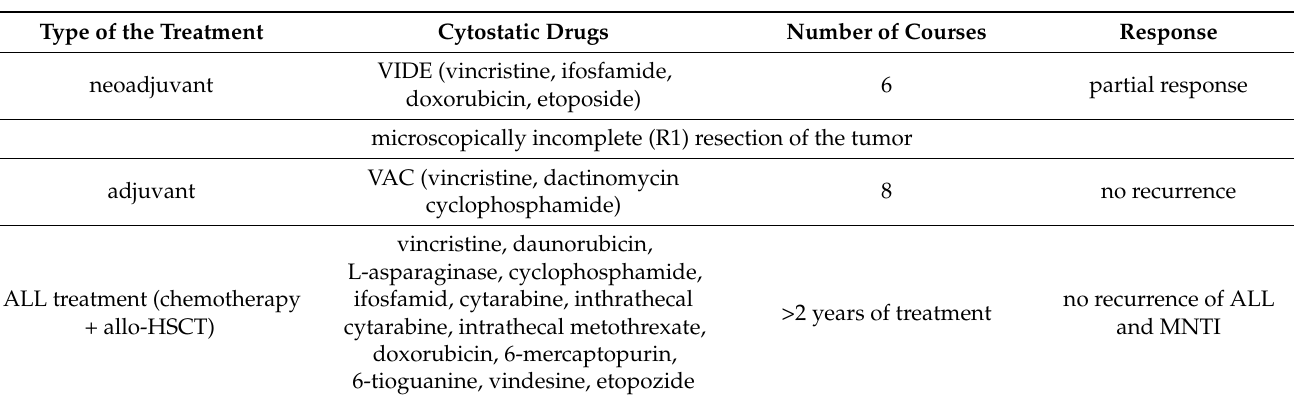
Table 2. Chemotherapy in patient